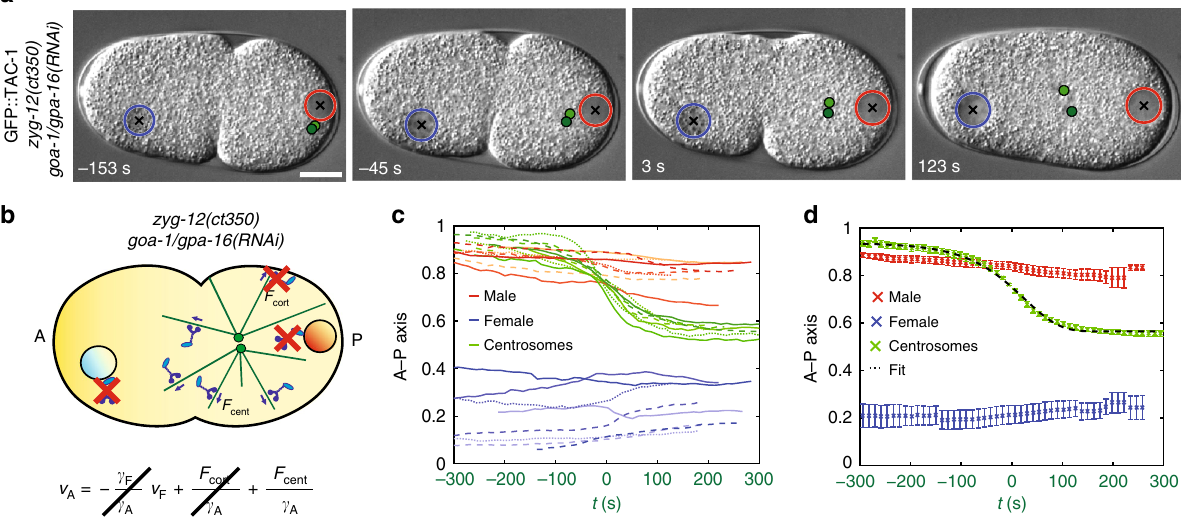
Fig. 2 Centrosome movements upon depletion of cortical and nuclear dynein reveal centering force dynamics. a , b Snapshots and schematics of centrosome centration in zyg-12(ct350) goa-1/gpa-16(RNAi) embryos. Since pronuclear meeting does not occur in zyg-12(ct350) goa-1/gpa-16(RNAi) embryos, in this fi gure time 0 s is de fi ned as the half-centration time (indicated by the green lettering on the x axis in c and d ; Methods). In b of this and subsequent fi gures, the red crosses represent depleted dynein motors. c , d Pronuclei and centrosome midpoint positions along the A – P axis as a function of time in eight zyg-12(ct350) goa-1/gpa-16(RNAi) embryos ( c ), as well as their average, represented with S.E.M. d Black-dashed line in d : fi t with sigmoidal model (Eq. 4 — Methods, χ 2 = 27, P =